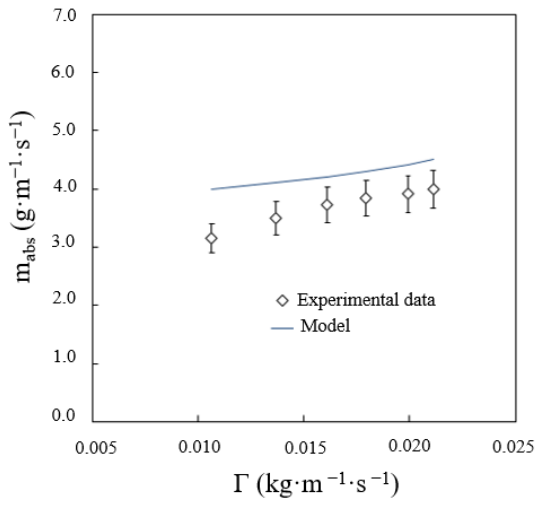
Figure 11. Effect of solution flow rate on the vapour absorption rate.